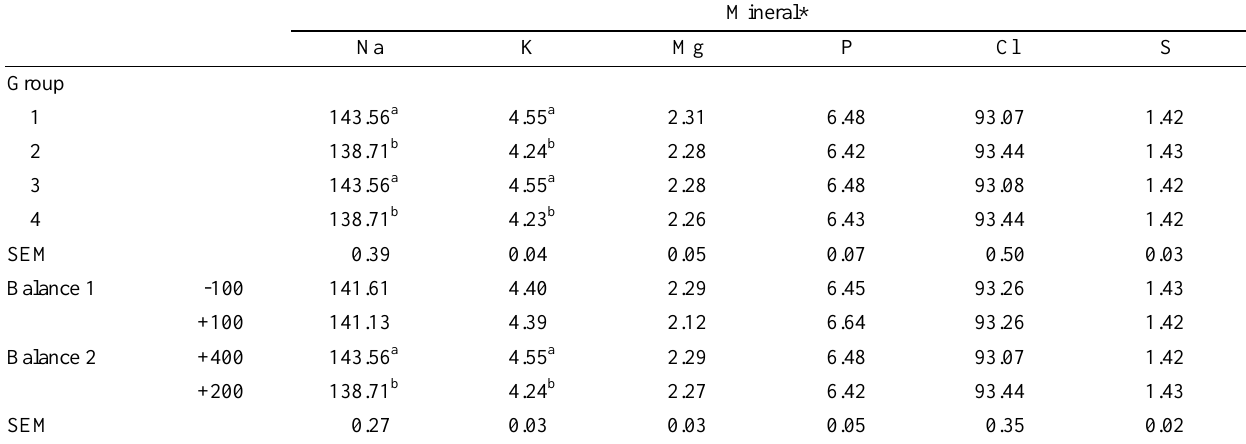
Table 4. The effect of dietary cation-anion difference on plasma minerals concentrations in postpartum period Mineral* Na K Mg P Cl S Group